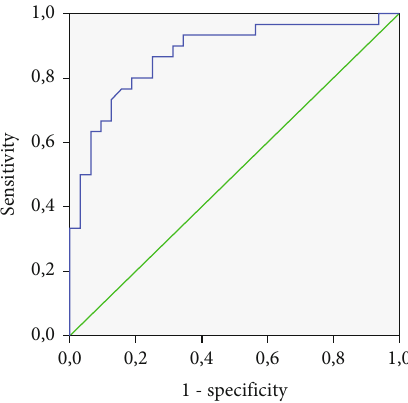
Figure 2: Galectin-3 level and HFpEF incidence.